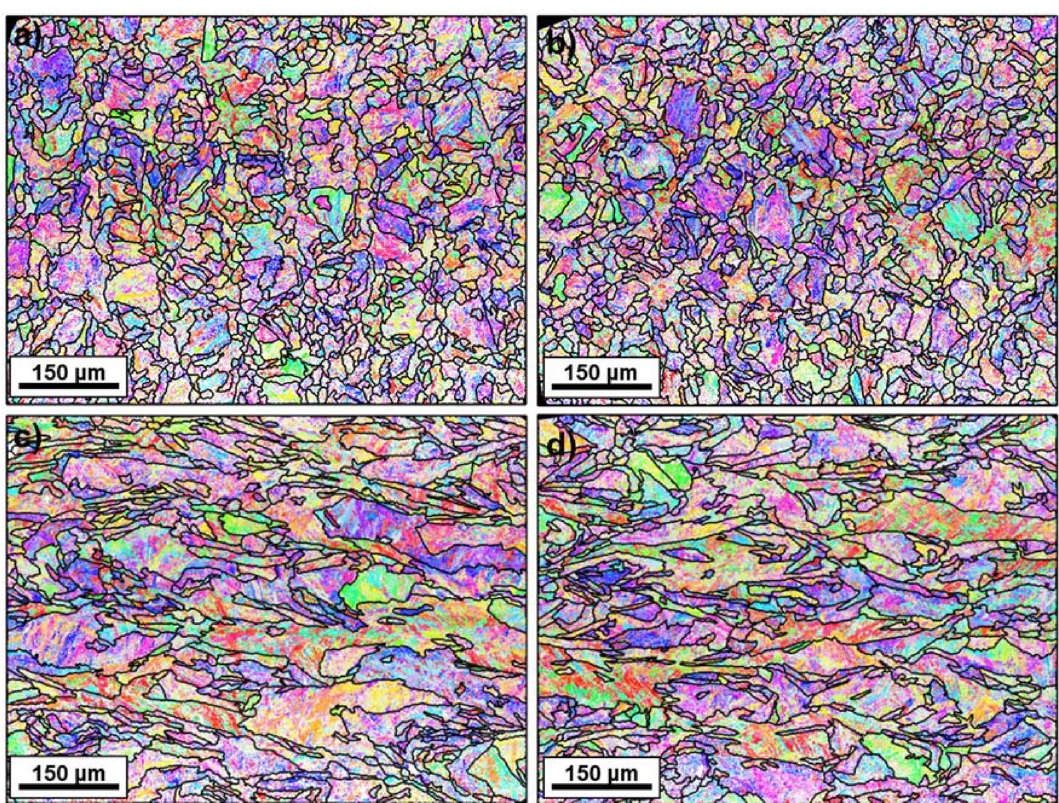
Figure 4. Martensite EBSD maps of the EOS—40 μm—CW laser condition, taken on the ( a , b ) transverse section and ( c , d ) longitudinal section. Pixels are colored according to their Inverse Pole Figures (IPF) color, corresponding to the building direction—perpendicular to the map for ( a , b ) and horizontal for ( c , d ). Prior austenite grain boundaries are superimposed on the